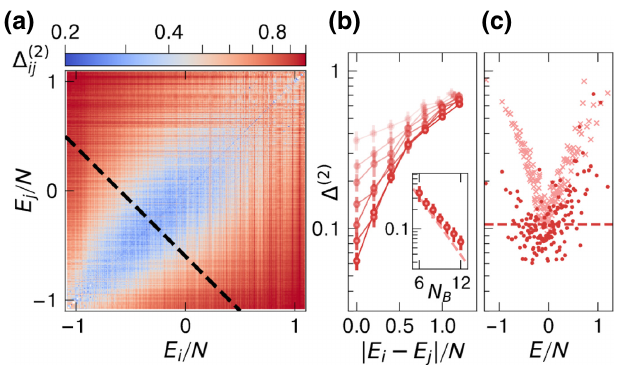
FIG. 5. A universal ensemble at finite temperature. (a) The trace distances between the second moments of the projected ensembles generated from a pair of energy eigenstates at E i and E j for N A = 3 subsystems. We plot the pairwise distances (cid:10) ( 2 ) for every pair of eigenstates | E i (cid:2) , | E j (cid:2) , computed for system ij size N = 11. The distances are minimized when E i ≈ E j . The plot suggests the existence of a universal ensemble that depends smoothly on the energy density. The black dashed line indicates a cut defined by ( E i + E j )/ N = − 0.6. (b) The trace distances plot- ted as a function of the energy-density difference, | E i − E j | / N , along the black dashed line in (a) for various systems sizes N = 9, 10, . . . , 15 (darker colors for increasing N ). The inset shows that the distances at zero energy difference E i = E j decay exponentially with the system size. The trace distances from the projected ensemble are comparable to those from the finite-size , of the empirical Haar distribution (dashed line). ensemble, (cid:10) ( 2 ) em Such an exponential scaling suggests the existence of a universal random ensemble at finite temperatures, which we hypothesize (dark to be the Scrooge ensemble . (c) The trace distance (cid:10) ( 2 ) E red, dots) between the second moments of the projected ensemble and the corresponding Scrooge ensemble of eigenstates | E (cid:2) , for remains small for a N A = 3 subsystem of a N = 14 system. (cid:10) ( 2 ) E eigenstates | E (cid:2) in a wider energy range E / N ∈ [ − 0.5, 0.5], with an average value of (cid:10) ( 2 ) = 0.11 (dashed line). In contrast, the trace distance between the projected and Haar ensembles (light red, crosses) is strongly energy dependent and is large at energies away from infinite effective temperature E =